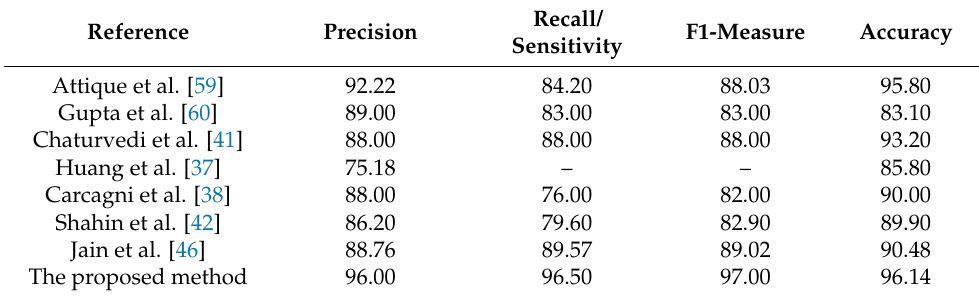
Table 4. Comparison of the proposed method with state-of-the-art methods.